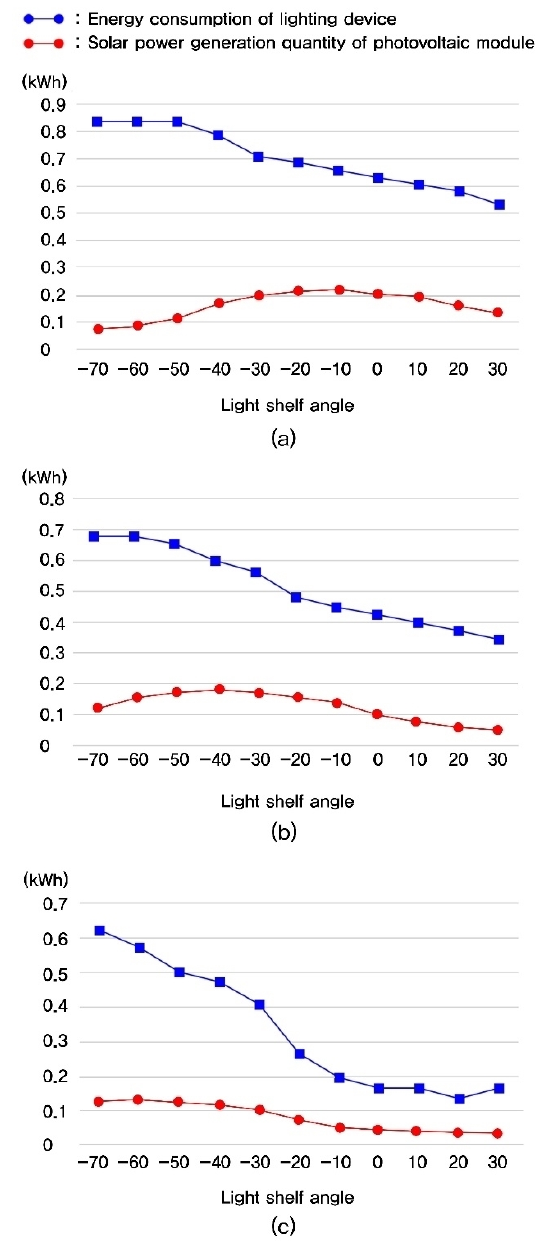
Figure 10. Lighting energy consumption and the power generated by the photovoltaic module ac- cording to the light shelf angle in Case 2: ( a ) Summer, ( b ) Mid-season, ( c ) Winter.